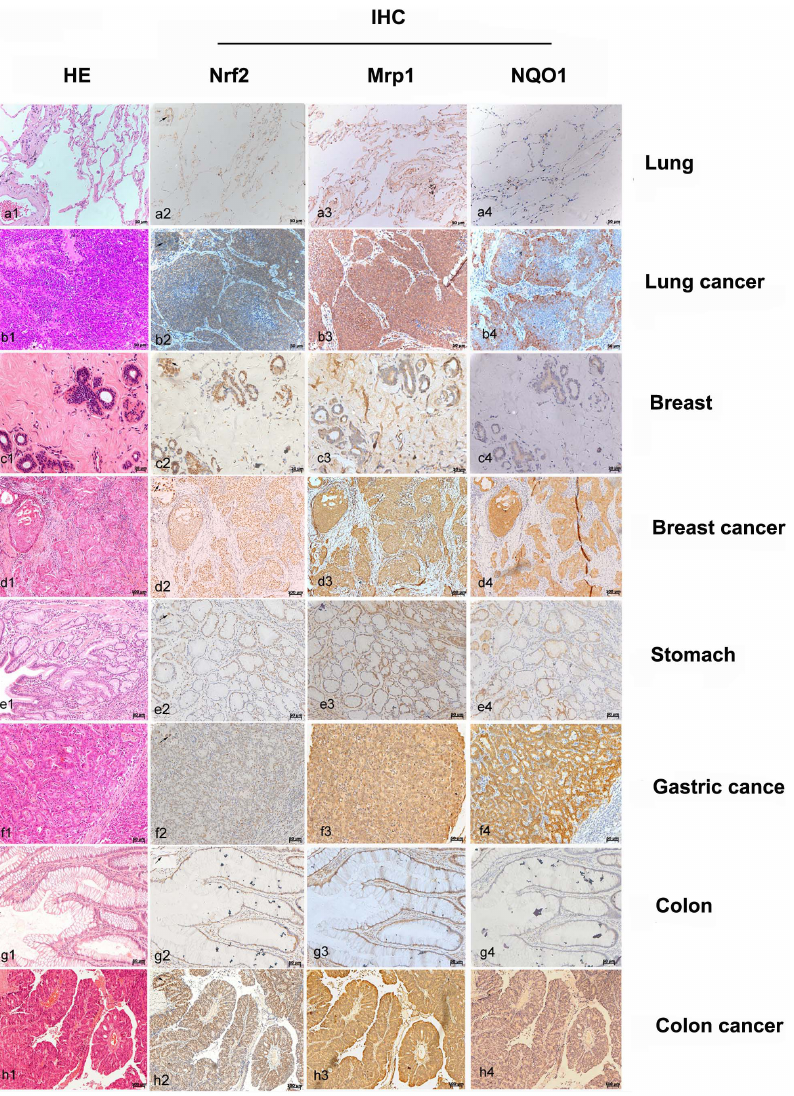
Figure 6. Immunohistochemical staining results for Nrf2, NQO1 and Mrp1 expression in cancer tissuess. The unstained tissue slides from small cell lung cancer, gastric cancer, breast cancer and colon cancer were subject to HE staining (a1 to h1) and IHC staining with antibodies against Nrf2 (a2 to h2), Mrp1 (a3 to h3) and NQO1 (a4 to h4). The bar scales were labeled at the lower right corner of each pictures.